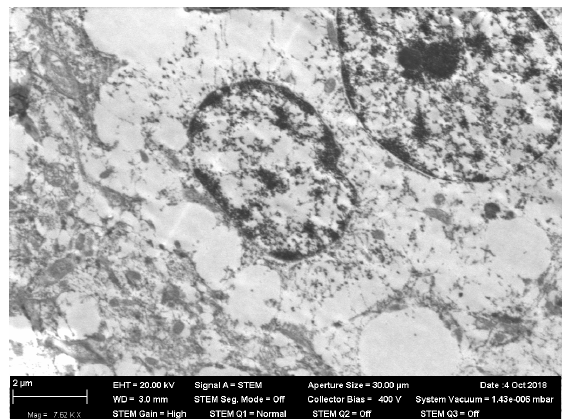
Figure 1. Nanoparticles in the body of a neuron in an olfactory bulb of rat brain after 3 months of inhalation exposure to NIO-NPs at a concentration of 0.23 mg/m 3 . STEM; magnification: 13790×. (See within the yellow oval.)